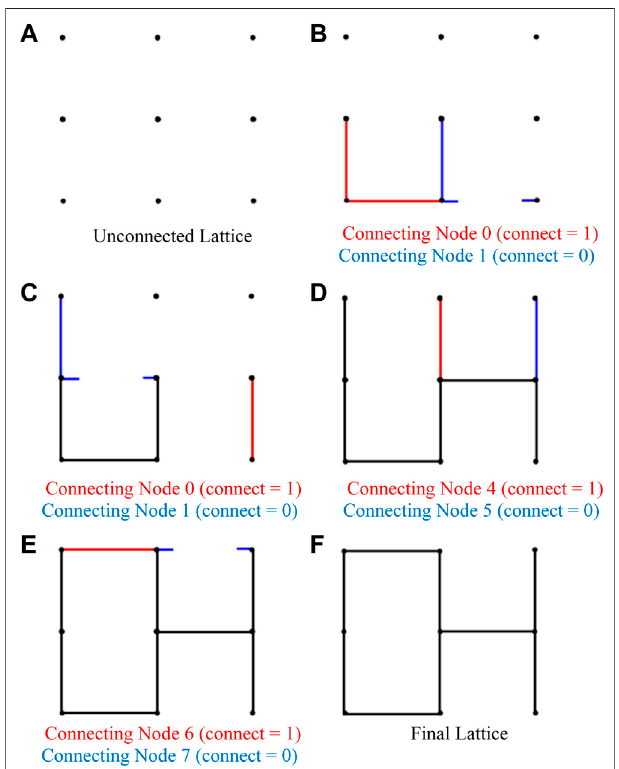
FIGURE 12 | Formation of 3 × 3 hexagonal lattice. (A) Unconnected lattice. (B) Connectingnode0(connect=1),Connectingnode1(connect=0). (C) Connecting node 0 (connect = 1), Connecting node 1 (connect = 0). (D) Connecting node 4 (connect = 1), Connecting node 5 (connect = 0). (E) Connecting node 6 (connect = 1), Connecting node 7 (connect = 0). (F) Final